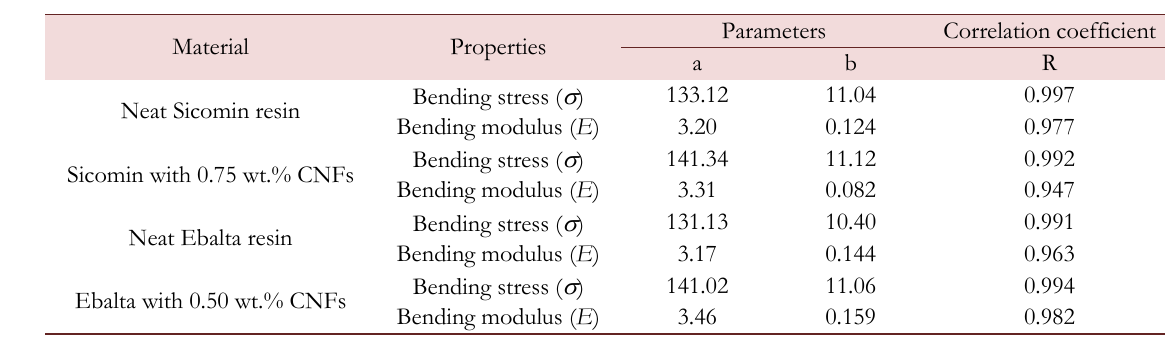
Table 4: Parameters of the equations that fits the effect of the strain ‐ rate on the nanocomposites.